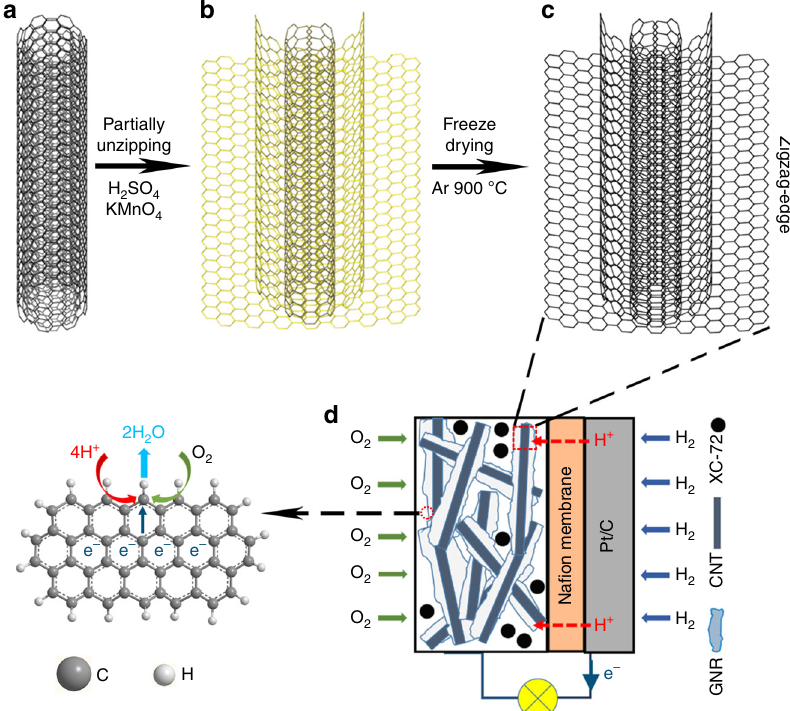
Fig. 1 Schematic illustration. The synthetic route of zigzag-type graphene nanoribbons on carbon nanotubes (GNR@CNT) from a MWCNT to b partially unzipped oxidized CNT and to c GNR@CNT. d The application as oxygen reduction reaction catalyst in a proton exchange membrane fuel cell (PEMFC). Carbon black XC-72 is used as spacer to prevent the stacking of active